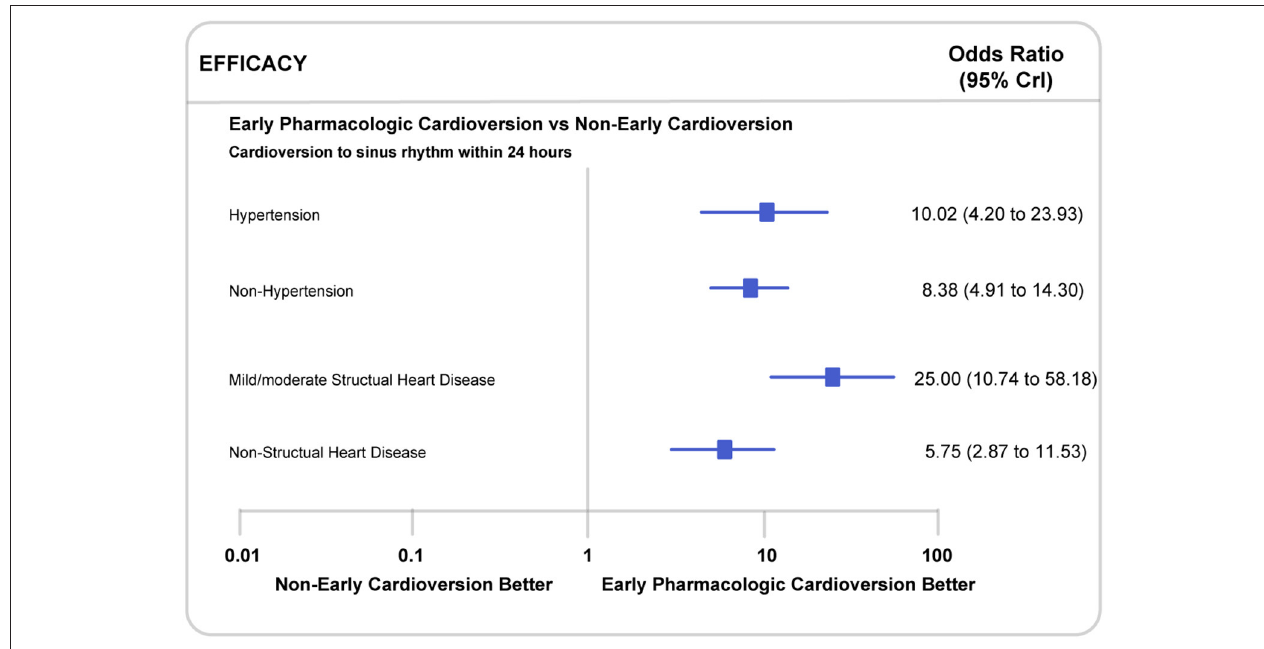
FIGURE 5 | Subgroup analyses in recent-onset atrial fibrillation patients with or without mild/moderate structural heart disease or hypertension. CrI, Credible